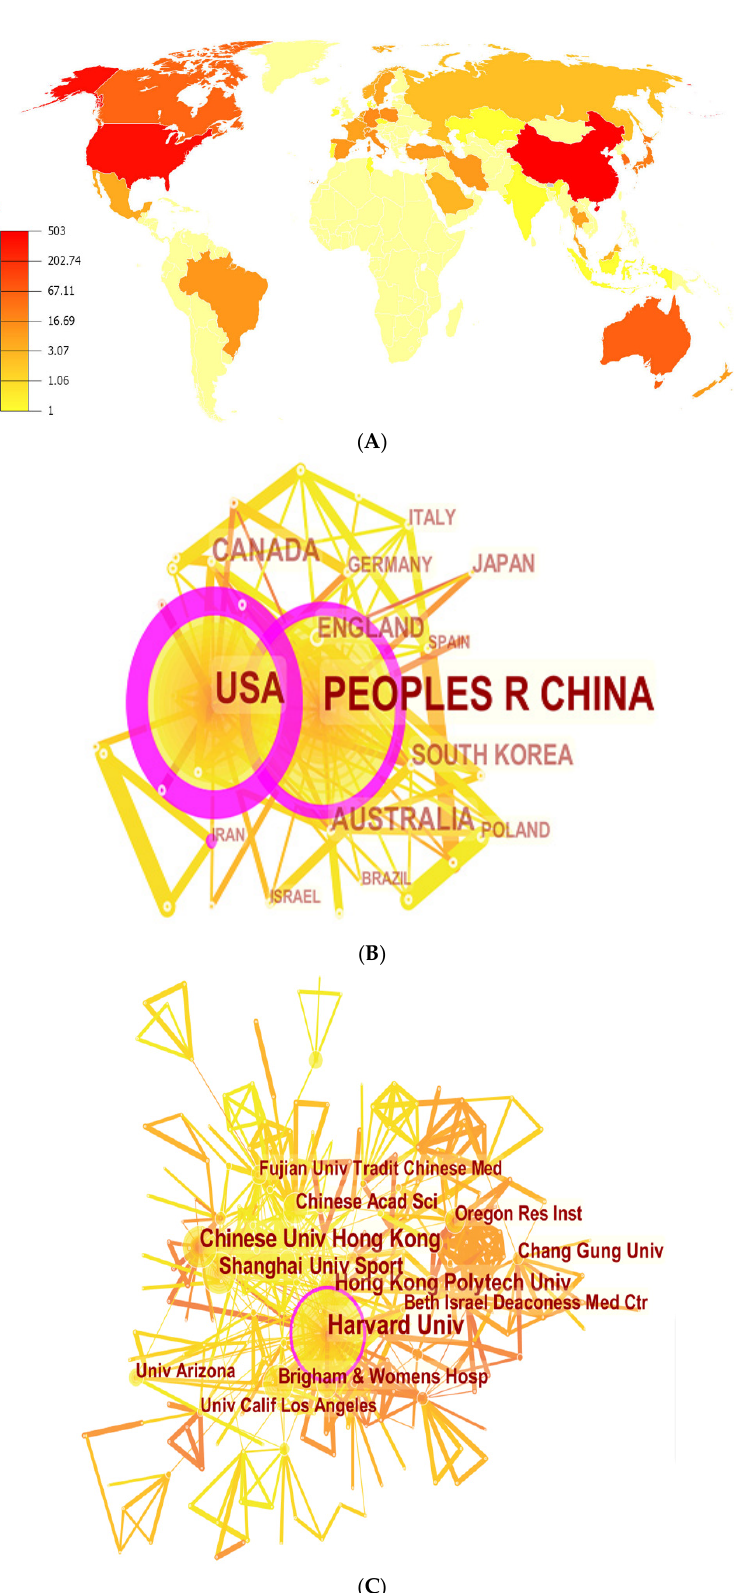
Figure 2. ( A ) Map of world distribution with publications in the field of Tai Chi research; ( B ) Map of countries with publications in the field of Tai Chi research; ( C ) Map of institutions with publications in the field of Tai Chi